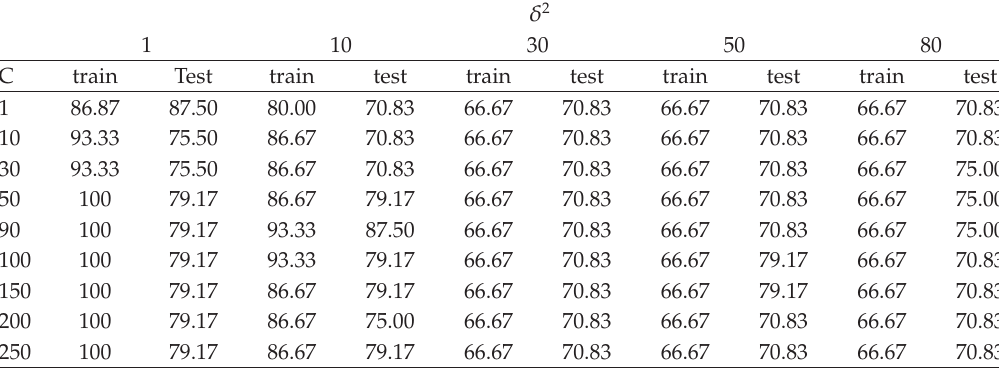
Table 2: Classification accuracies of various parameters in the first model.